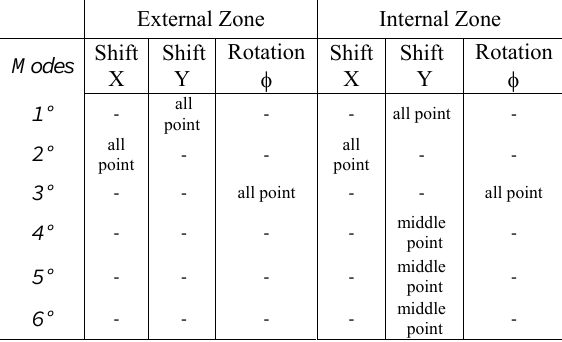
Figure 14 describes the comparison between the evaluated main modal periods (frequencies) and the Fourier Spectrum of the recorded signals of the first FEM model.